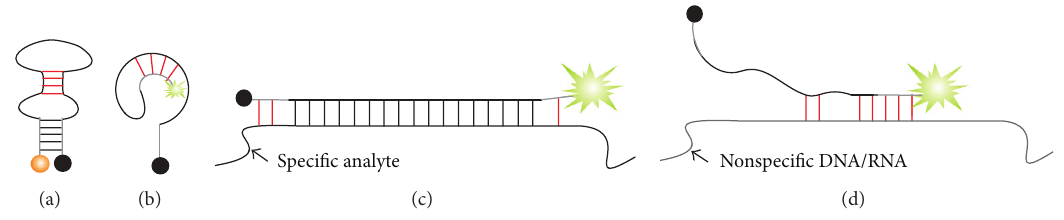
F 4: Examples of loop and stem interferences in MB probe. (a) Loop interference. Complementary loop nucleotides hybridize to each other, thus making folded conformation more stable and less accessible by the target analyte. (b) Stem hybridizes to loop thus separating the �uorophore from the quencher resulting in elevated background signal. (c) Stem nucleotides can partially hybridize to the nucleotides of the targeted analyte. (d) Stem and loop nucleotides bind nonspeci�c nucleic acids present in a sample. �ed lines indicate undesired or undesigned base pairs.